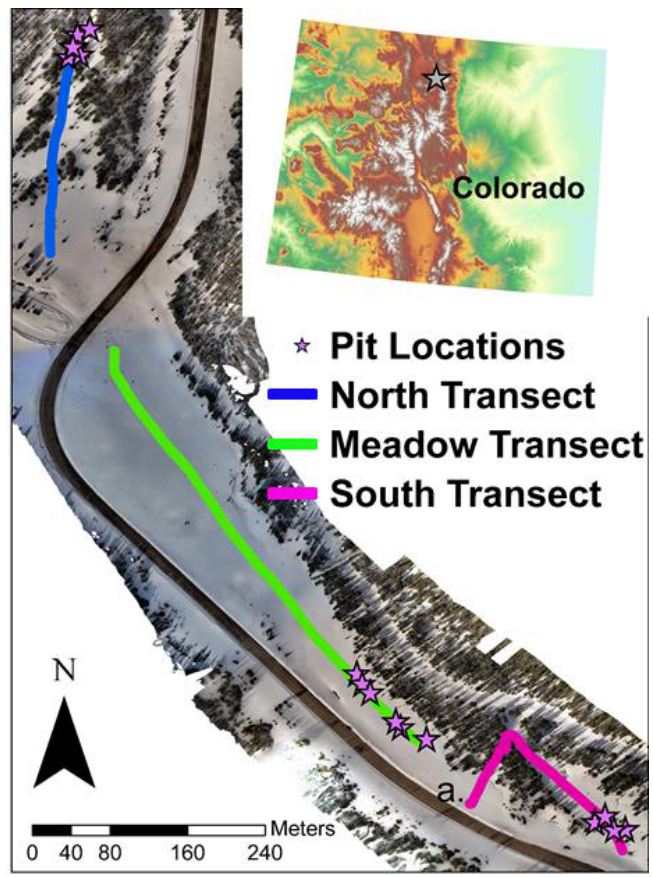
Figure 2. Cameron Pass field site. The three transects are shown by the colored lines and snowpit locations are marked by stars. The inset shows the location for Cameron Pass within Colorado, USA. Orthomosaic derived from sUAS survey in March 2020. DEM in inset obtained from the Shuttle Radar Topography Mission (https://srtm.csi.cgiar.org/, accessed on 14 May 2019). Marker a. denotes the western terminus of the South Transect.